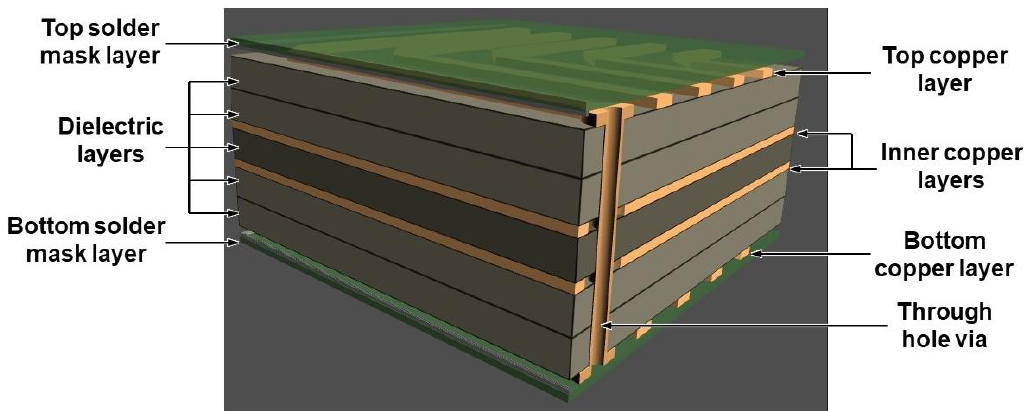
Figure 1. A 3-D schematic design of a multi-layer printed circuit board (PCB) board composed of four copper layers (two internal layers), five dielectric layers, and the top and bottom mask layer. Finishes on the board surface protect exposed copper and provide solderable surfaces.